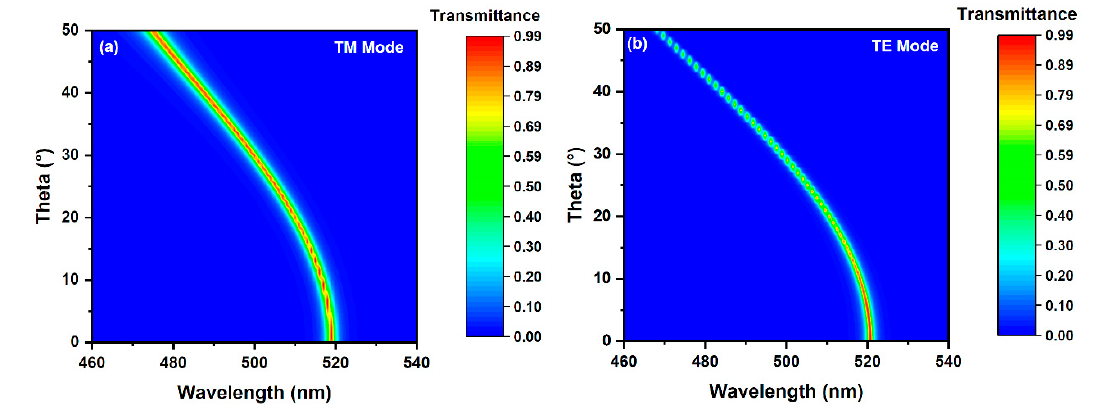
Figure 11. Evolution of the transmissive spectrum in TM ( a ) and TE ( b ) as the incident angle in- creases.